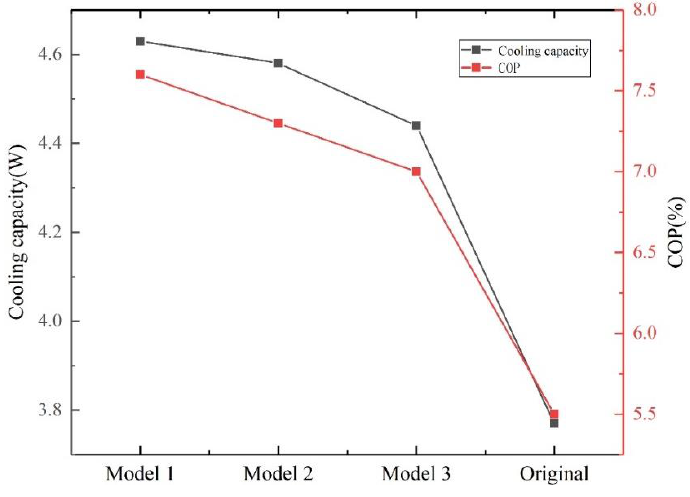
Figure 9. Cooling capacity and COP at 120 K.